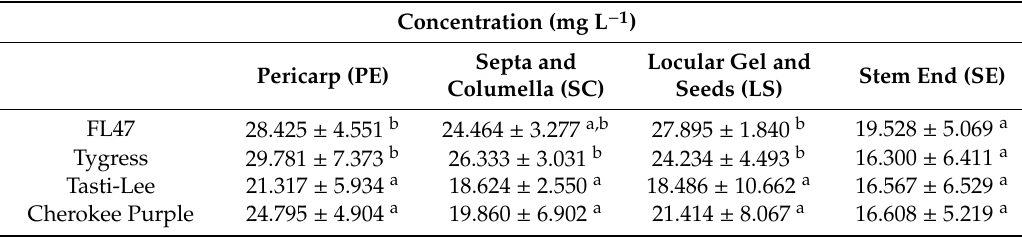
Table 5. Volatile total concentrations per